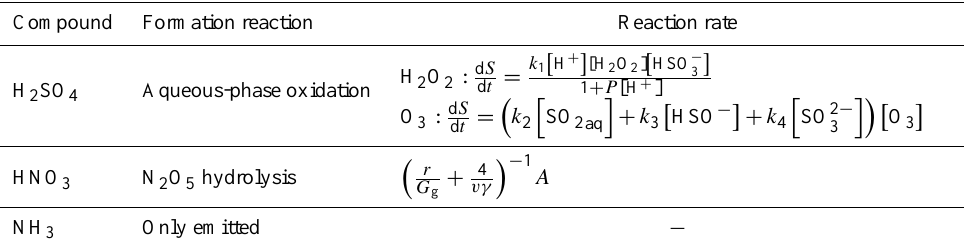
Table 1. Summary of the heterogeneous formation processes of secondary inorganic aerosol precursors that have been in the model. k 1